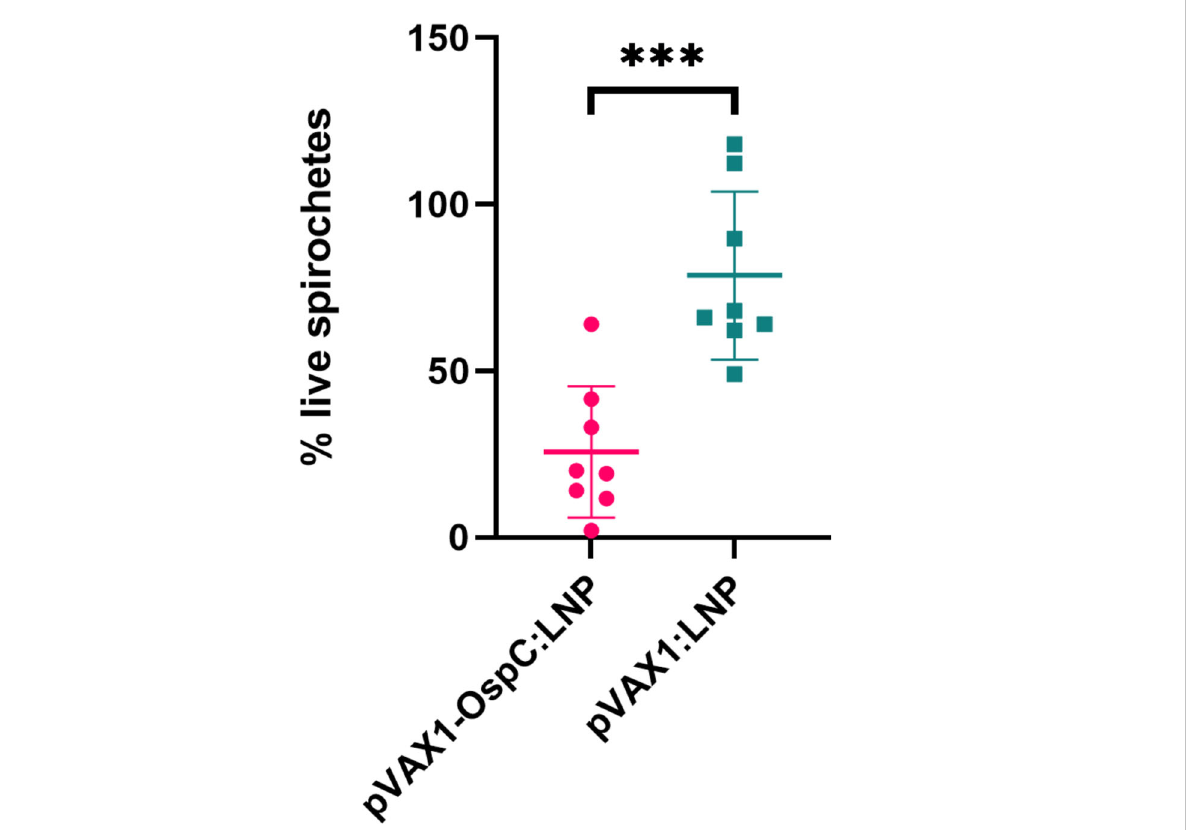
FIGURE 2 pVAX1-OspC:LNP vaccination generates borreliacidal antibodies. Serum from vaccinated or naïve mice was collected three weeks after boost injection (day 49) and incubated with B. burgdorferi -OspC-con for 24 hours. Motile B. burgdorferi cells were enumerated by dark fi eld microscopy. Percentage live spirochetes represents the percentage of motile cells compared to naive serum control. Error bars represent standard deviation. *** p-value <